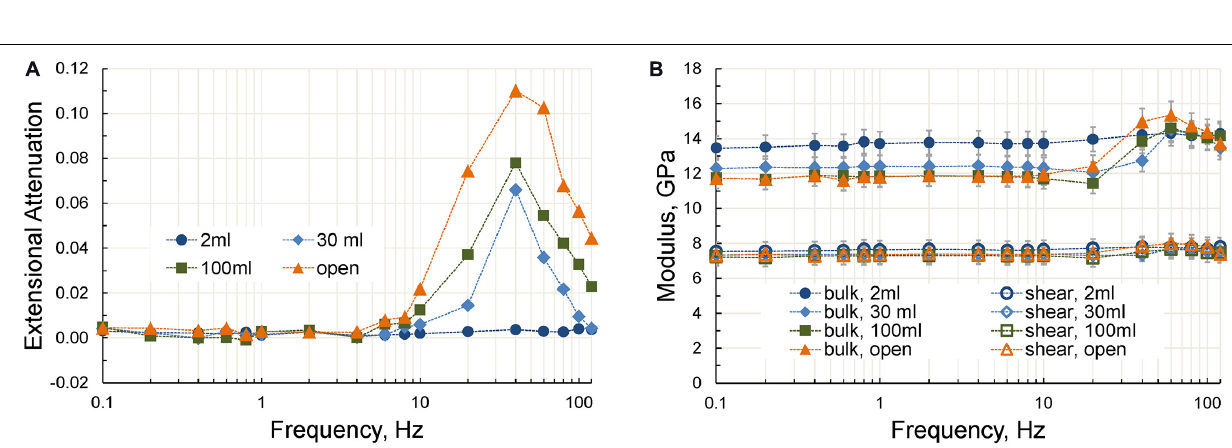
Frontiers in Earth Science |